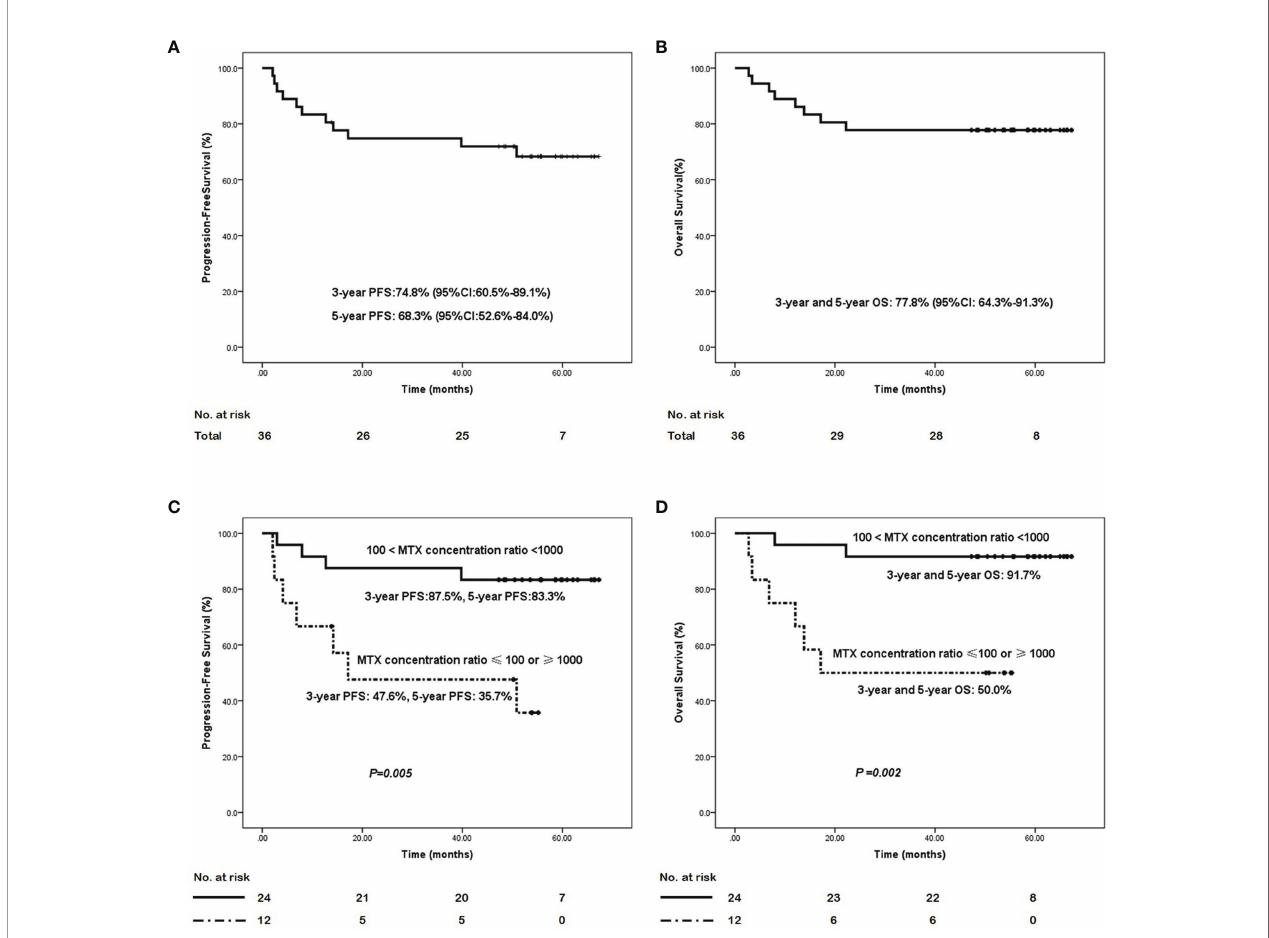
FIGURE 2 | The survival curves of the ENKTL patients with the GAD-M regimen. (A) progression-free survival curve and (B) overall survival curve in the 36 ENKTL treated with the GAD-M regimen. (C) progression-free survival curve and (D) overall survival curve in patients according to the plasma MTX concentration ratio from 12 to 24 hr of the fi rst cycle in the treatment with the GAD-M regimen.